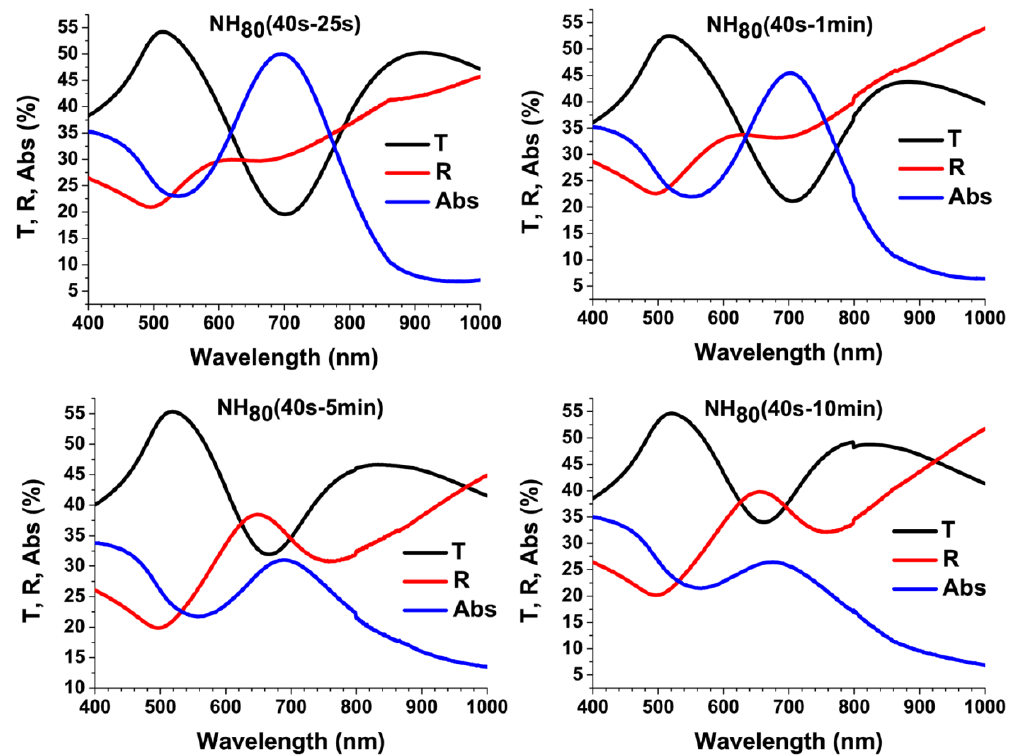
Figure 6. Transmittance (T), diffused reflectance (R), and absorbance (A = 100-R-T) spectra of the NH the NH samples NH 80 (40–25 s) ( topmost left panel ), NH 80 (40 s–1 min) ( topmost right panel ), samples NH 80 (40 s – 25 s) ( topmost left panel ), NH 80 (40 s – 1 min) ( topmost right panel ), NH 80 (40 s–5 min) ( bottom left panel ) and NH 80 (40 s–10 min) ( bottom right panel ), measured NH 80 (40 s – 5 min) ( bottom left panel ) and NH 80 (40 s – 10 min) ( bottom right panel ), measured under under normal incidence normal incidence conditions.